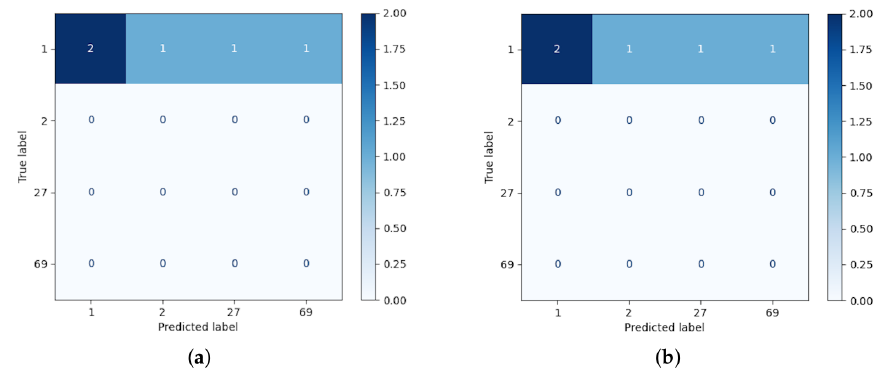
Figure 9. Example of separated confusion matrix obtained after the classification of layer 2. ( a ) Eu- clidean kernel. ( b ) Cosine